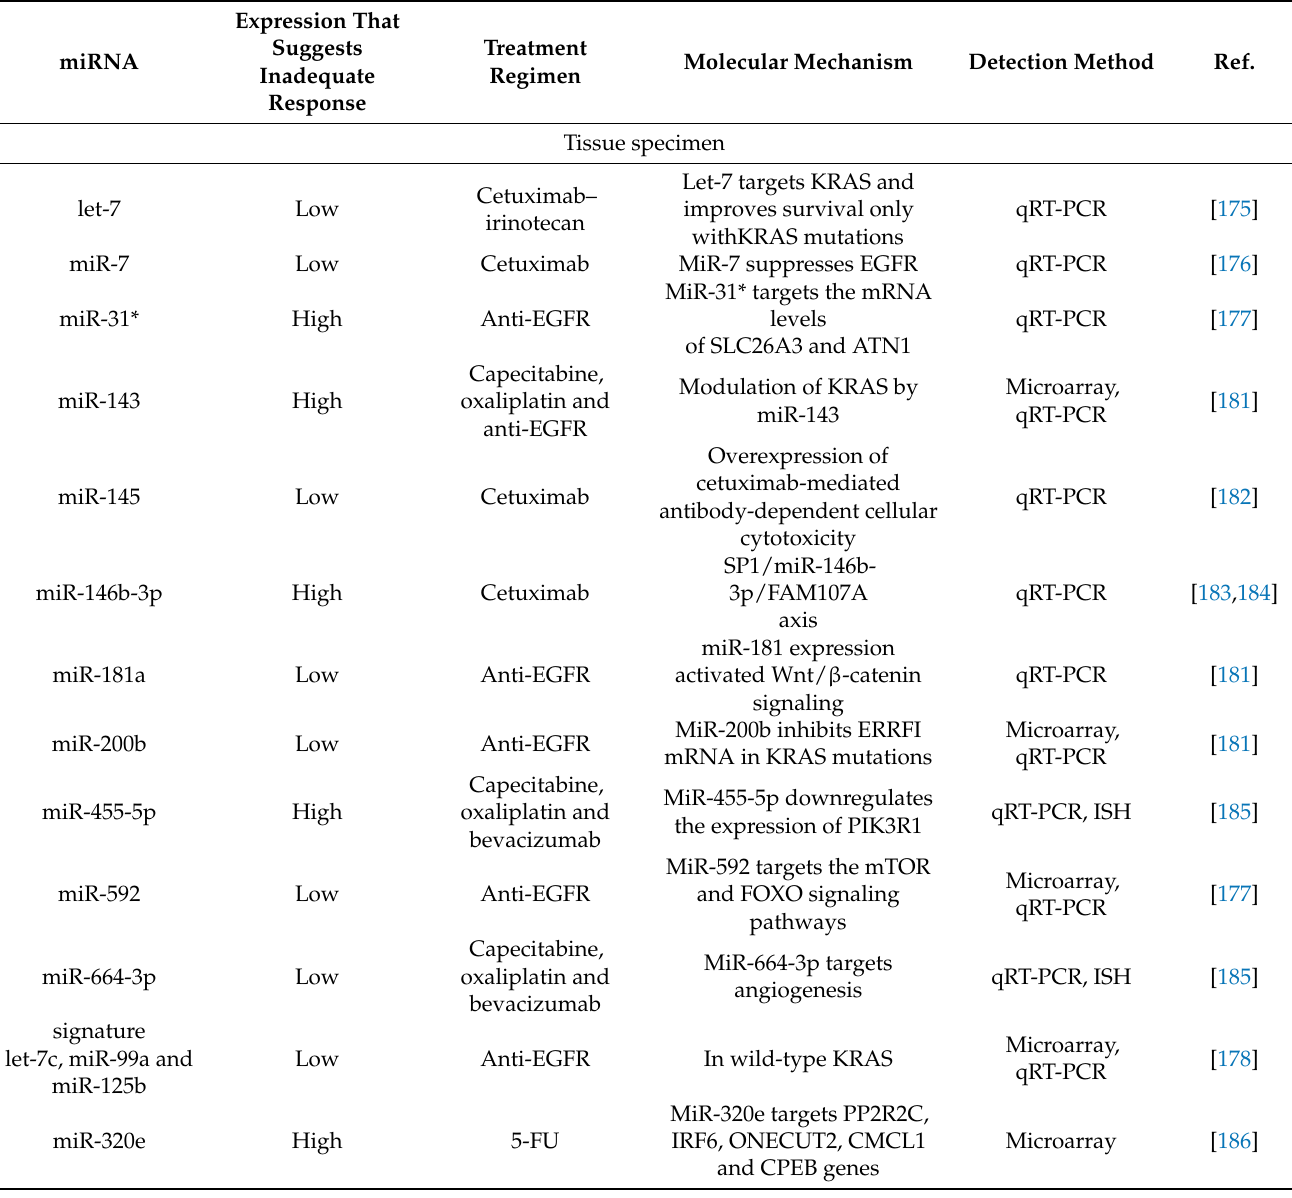
Table 2. MiRNAs from plasma, serum and exosomes for predicting the response to systemic therapy in